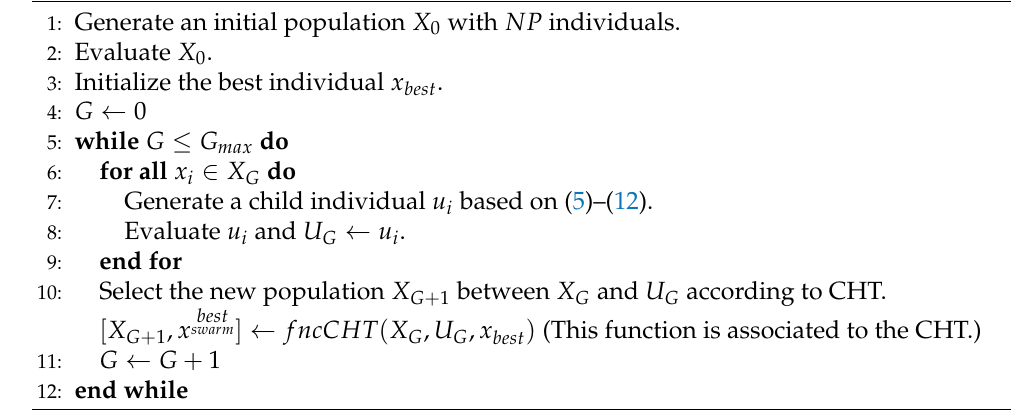
Algorithm 1 Differential evolution